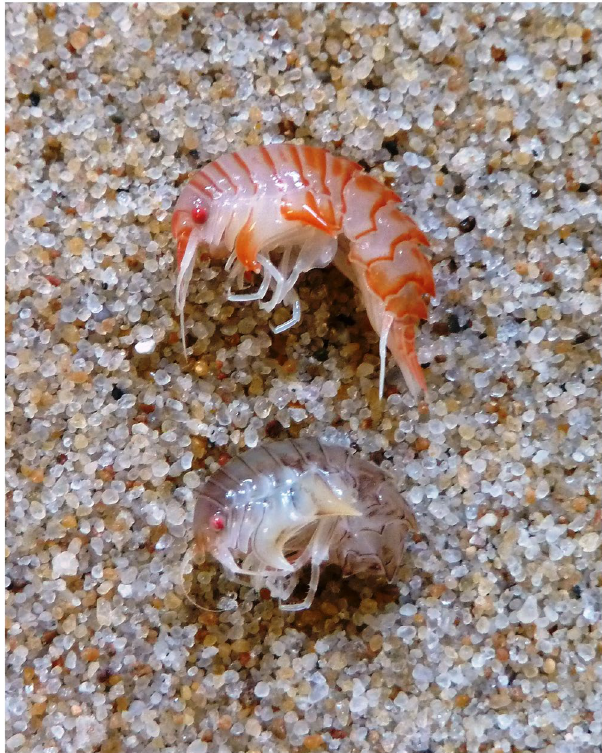
Figure 6. Photograph of freshly caught individuals of E . cornigera (top) and E . frankei sp. nov. (bottom); body colouration can clearly be used to discriminate the two